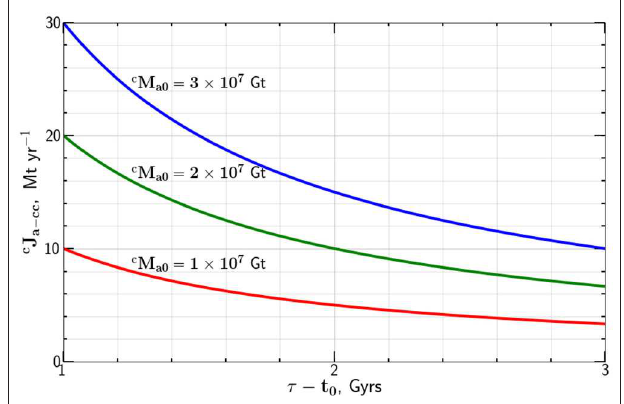
FIGURE 1 | Dependence of the constant mass flux of carbon from the atmosphere to the continental crust c J a − cc required to transfer the mass of carbon 1,2, and 3 × 10 7 Gt to the continental crust in a time τ − t 0